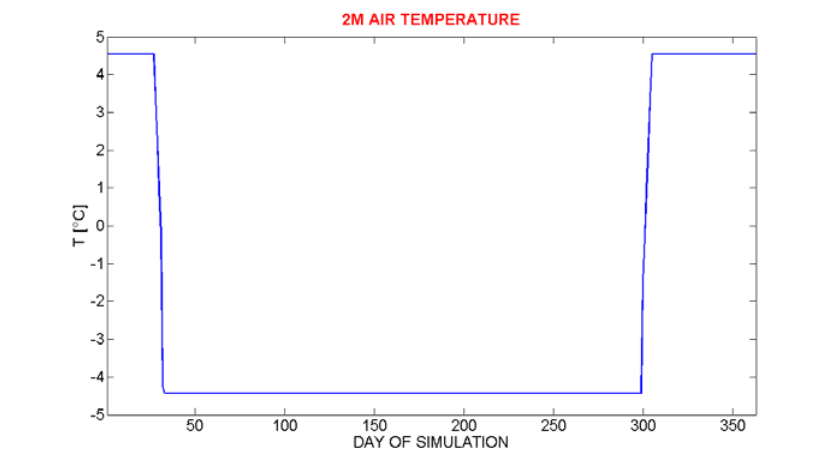
Figure 2. Daily mean 2 m temperatures used in the synthetic